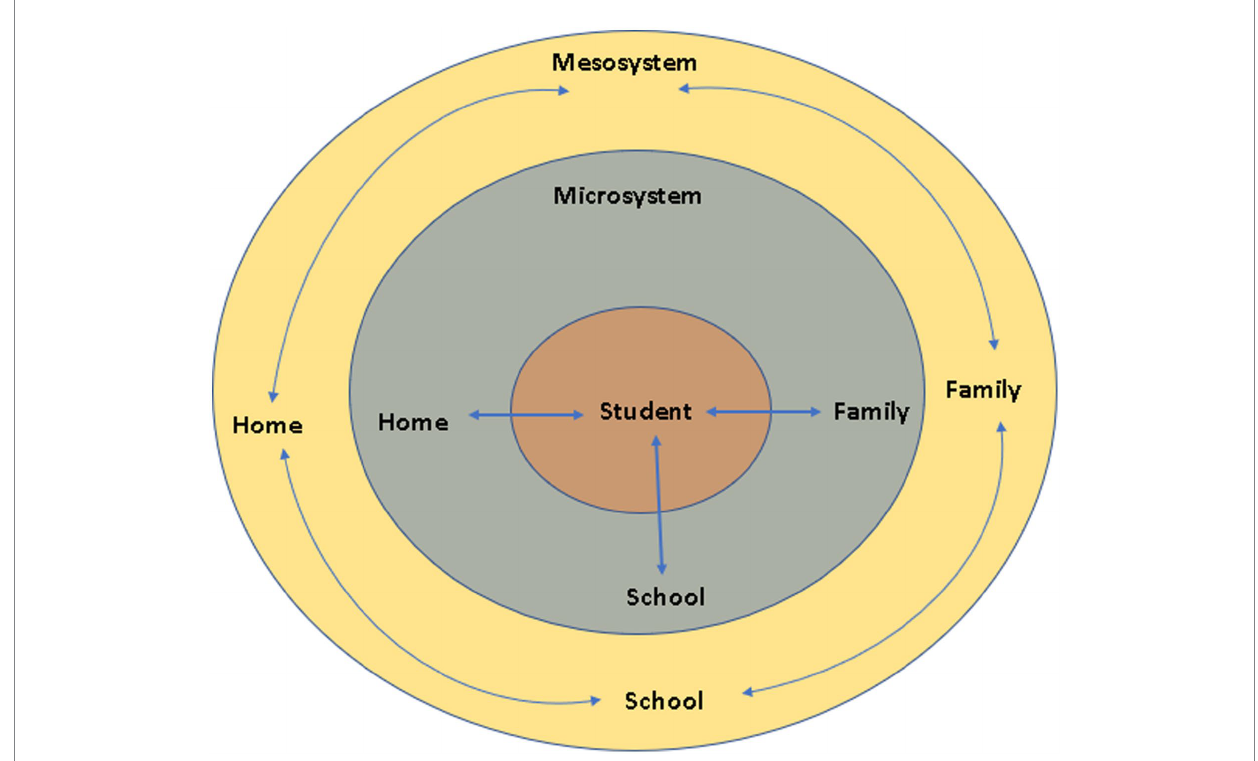
FIGURE 1 Hypothesized ecological model utilized in the present study with three